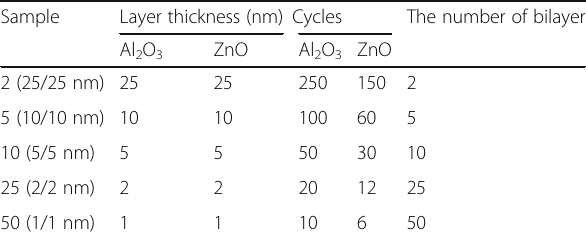
Table 1 The parameters of samples with different bilayer thicknesses Sample